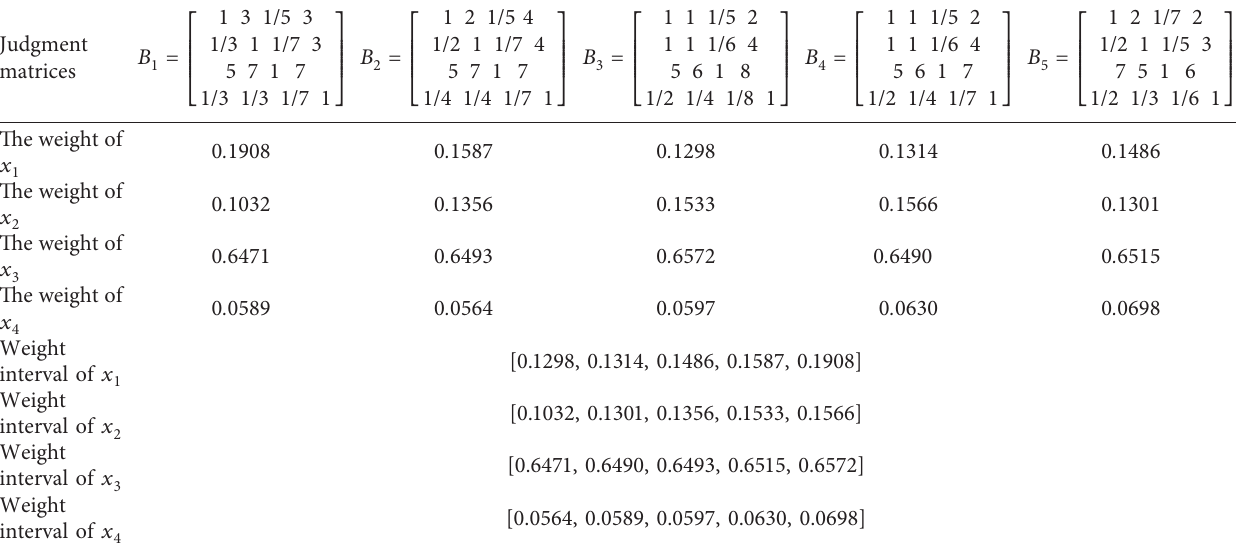
Table 2: Calculation results of variable weight interval under A13.